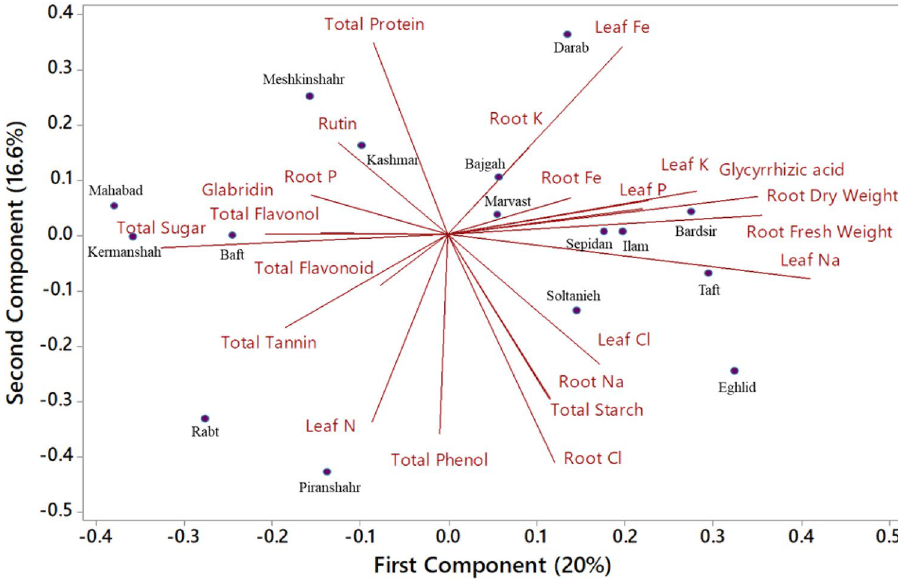
Figure 7. Principal component analysis of studied treatments on morphophysiological and biochemical characteristics of 16 Iranian licorice